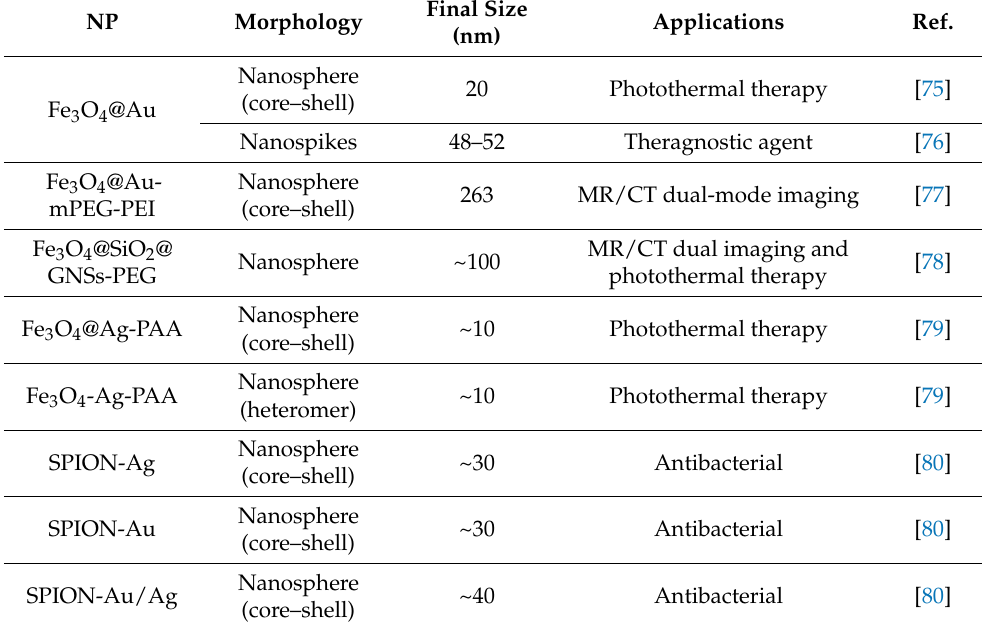
Table 4. Integration of noble metal NPs and magnetic NPs for biomedical